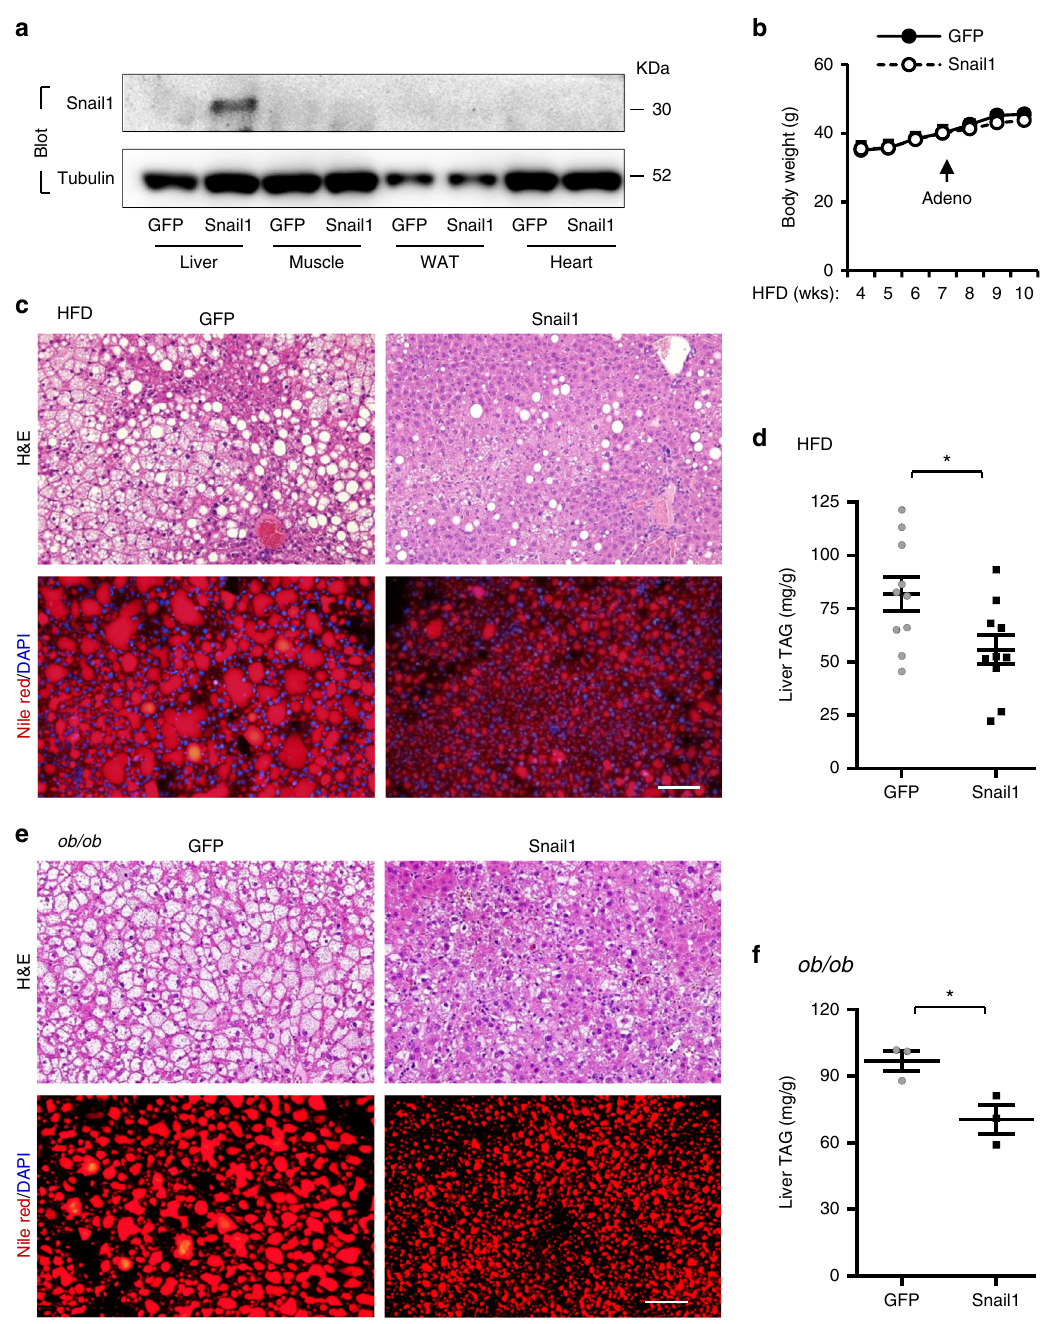
Fig. 4 Liver-speci fi c overexpression of Snail1 protects against NAFLD. a – d C57BL/6 male mice (8 – 9 weeks) were fed a HFD for 7 weeks and transduced with Snail1 ( n = 10) or GFP ( n = 10) adenoviral vectors. Livers were harvested 3 weeks after transduction. a Tissue extracts were immunoblotted with the indicated antibodies. b Growth curves. c Representative H&E or Nile red staining of liver sections. Scale bar: 100 µ m. d Liver TAG levels (normalized to liver weight). e , f ob/ob male mice (9 weeks) were transduced with GFP ( n = 3) or Snail1 ( n = 3) adenoviral vectors for 3 weeks. e Representative H&E or Nile red staining of liver sections. f Liver TAG levels (normalized to liver weight). Scale bars: 100 µ m. Data are presented as mean ± SEM. * p < 0.05, two-tailed unpaired Student ’ s t